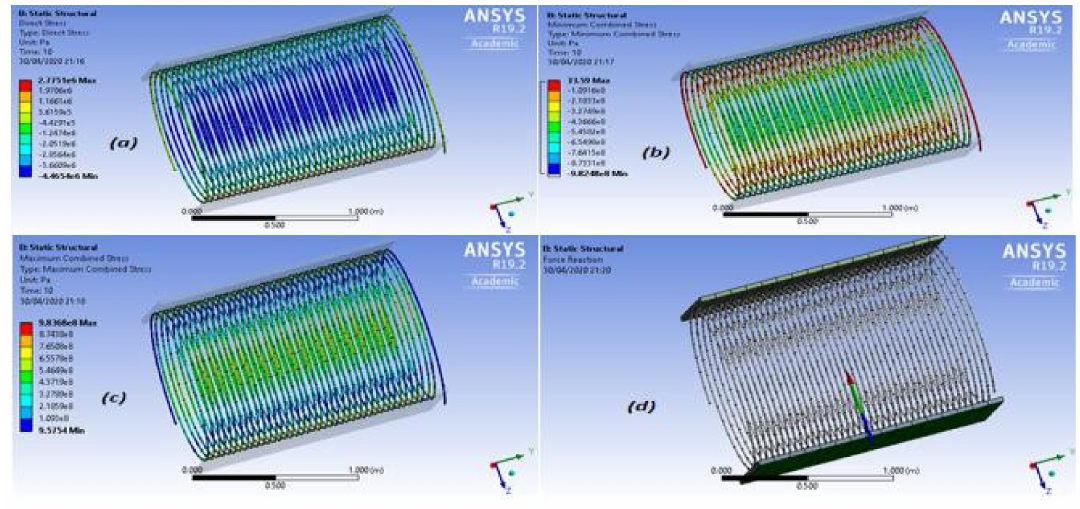
Figure 14. Helical spring beam model of the offshore bonded composite hose, showing ( a ) direct stress, ( b )minimum combined stress, ( c ) maximum combined stress, and ( d ) force